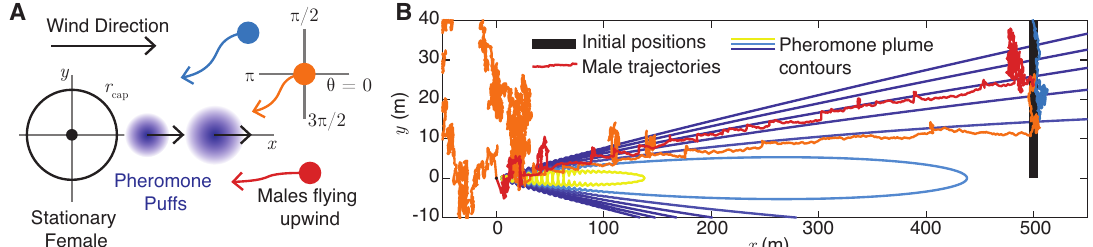
Figure 11. ( A ) Schematic of the agent-based Plume Navigation Model as described in Section 5. A stationary female at the origin releases pheromone puffs while male moths fly upwind toward her. Note the capture radius r cap and the presence of an advecting wind. ( B ) Representative